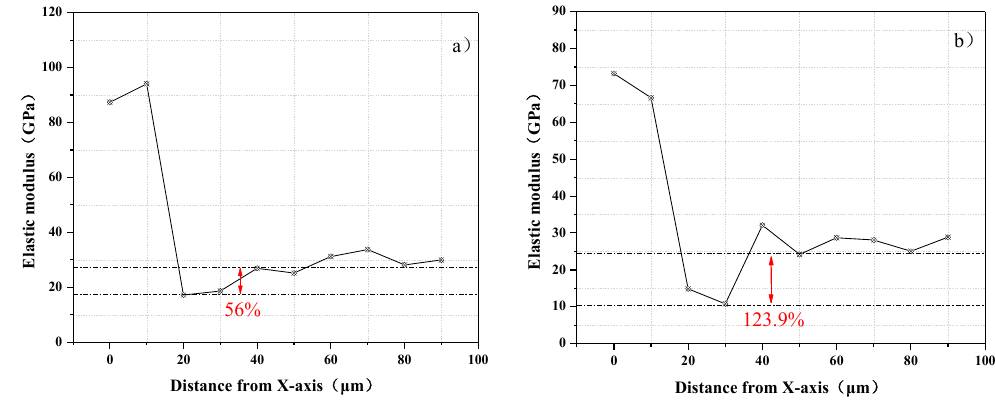
Figure 9. Results of nanoindentation experiments: ( a ) SCM-1; ( b ) SCM-4.